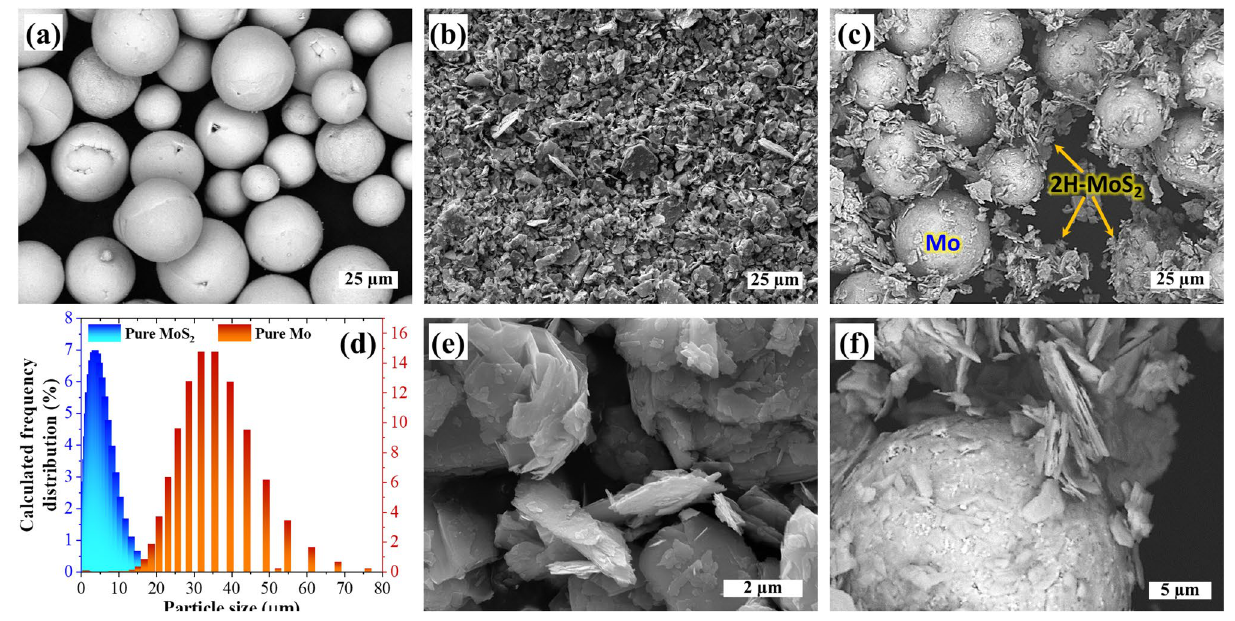
Figure 1. Scanning electron microscopy images of (a) pure Mo powder, (b) layered MoS 2 powder, and (c) Mo-MoS 2 powder mixture feedstock. (d) Particle size distribution plot of Mo and MoS 2 powders based on high-resolution scanning electron microscopy images of (e) layered MoS 2 powder and (f) the Mo-MoS 2 mixture